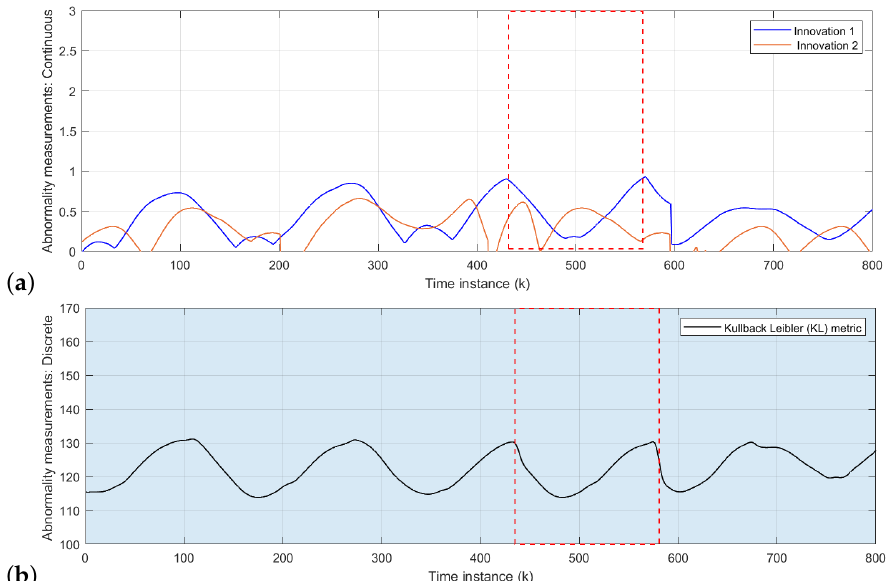
Figure 10. Abnormality measurements: Task 4 test data: ( a ): the blue and orange plots belong to the anomaly estimated for iCab1 and iCab2 , respectively. ( b ) Discrete level abnormality: the peaks show the global anomaly detected by the